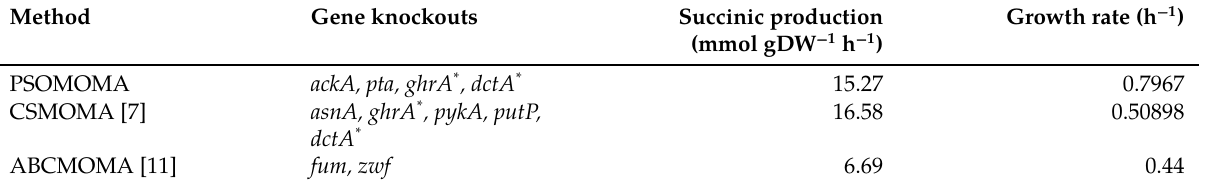
Table 3: Result comparison on succinate production for PSOMOMA, CSMOMA and ABCMOMA.